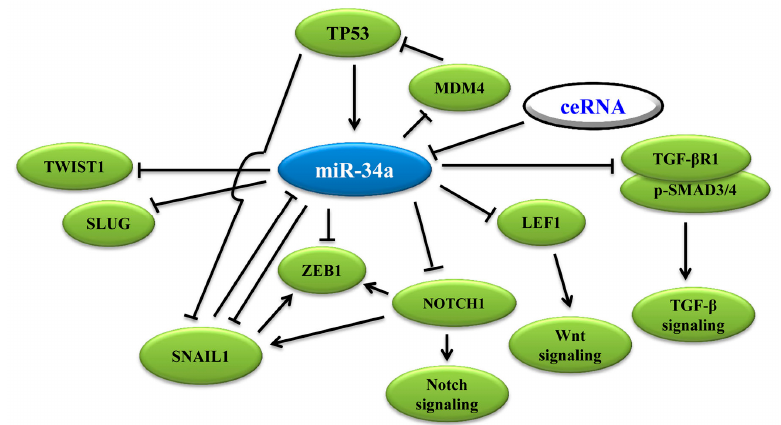
Figure 2. MiR-34a-controlled signaling for EMT. MiR-34a inhibits EMT-TFs, Notch signaling, Wnt signaling, and TGF- β signaling, whereas TP53, miR-34a, and NOTCH1 form feedback loops with each other for EMT. The competing endogenous RNAs (ceRNAs) is a novel concept about mRNAs, circRNAs, pseudogene transcripts and lncRNAs that regulate each other’s expression to compete for the binding of miRNA. Note: arrow indicates promotion, whereas t ‐ bar indicates inhibition.